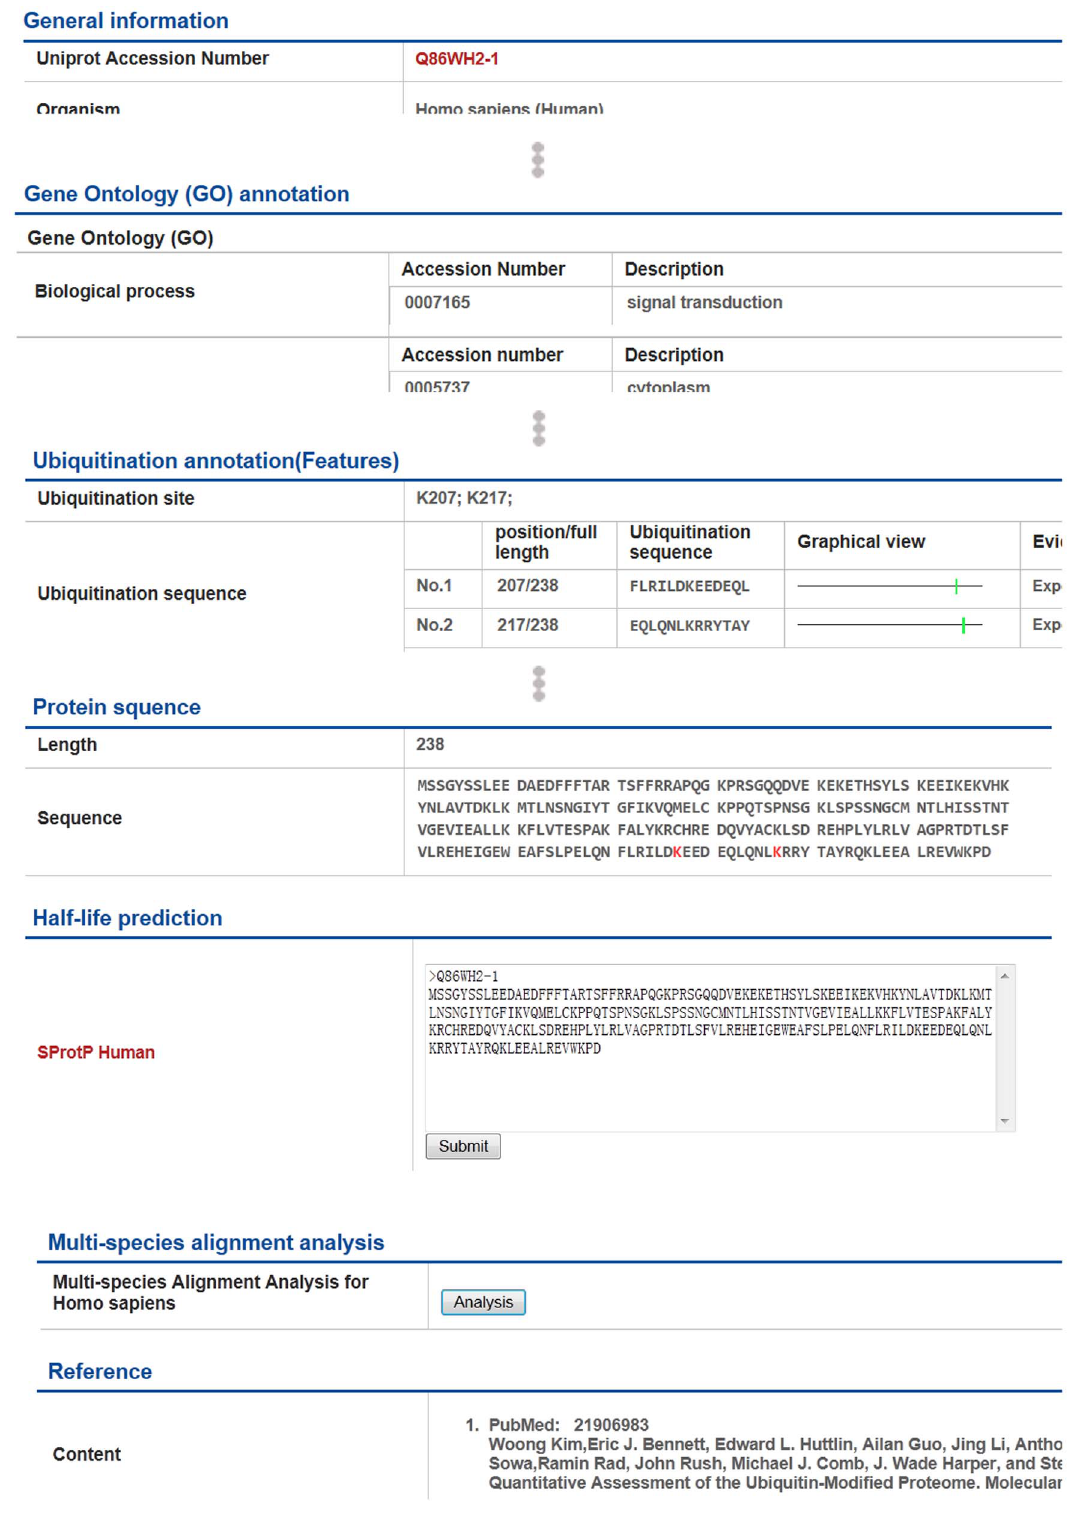
Figure 4. Detailed information page.